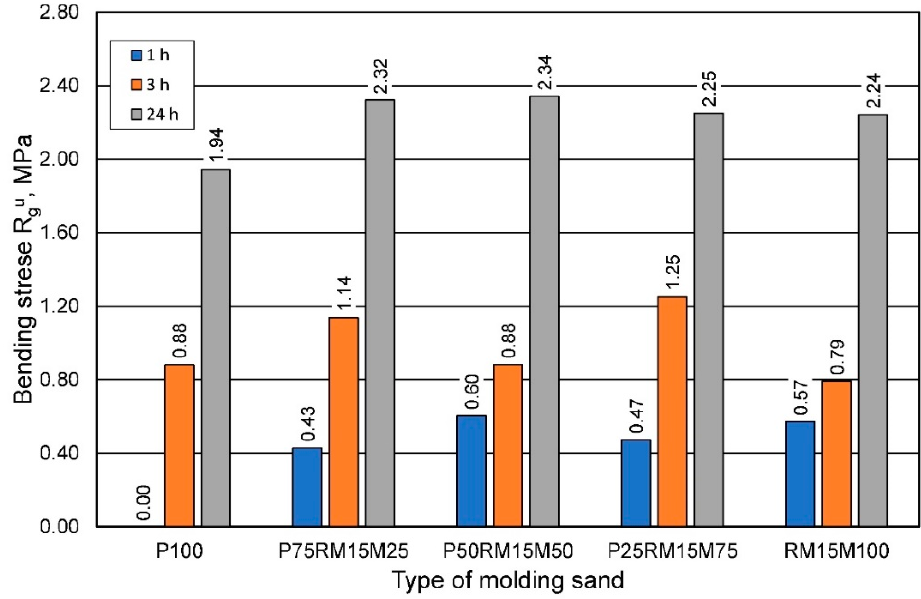
Figure 21. The bending strength R u g of the molding sand depends on the grain matrix used. Increasing the share of mechanical reclaim in fresh chromite sand adversely affects the permeability of the molding sand, as shown in Figure 22.